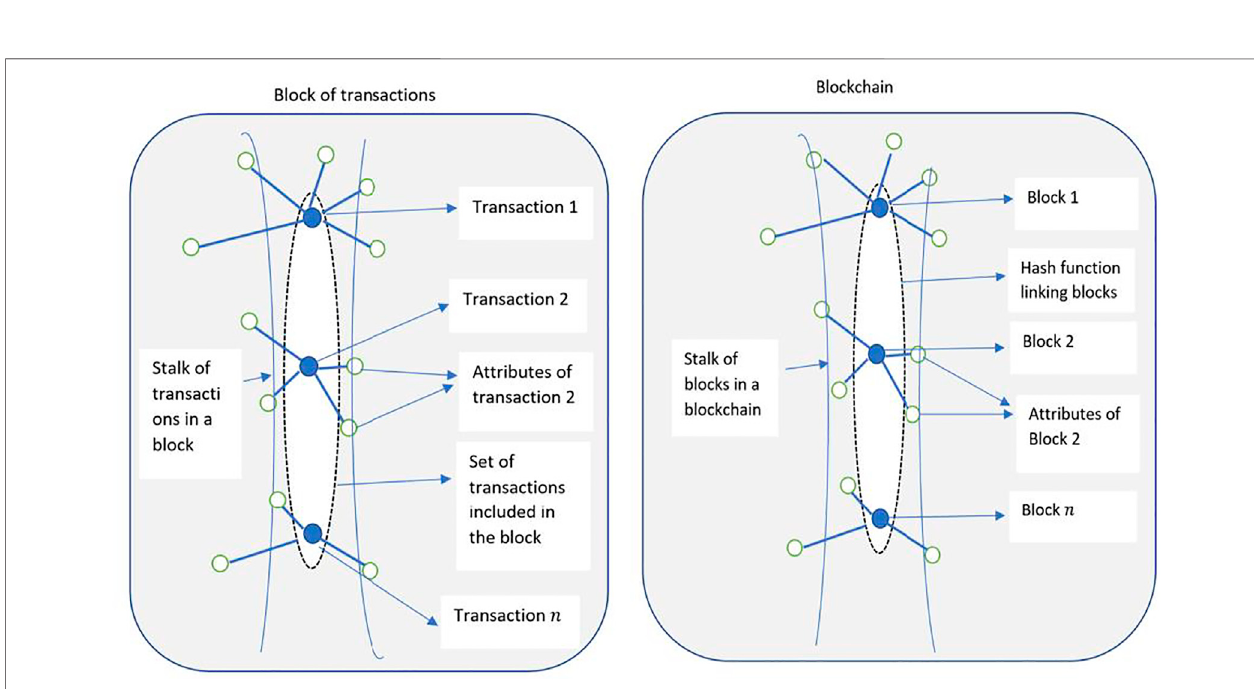
FIGURE5 | Left: Ablock oftransactions represented as a stalk. Individual transactions contain varying attributes. Right: A blockchain of n blocks represented asa stalk. Block-level and transaction-level attributes can be adequately represented in the sheaf-theoretic model.